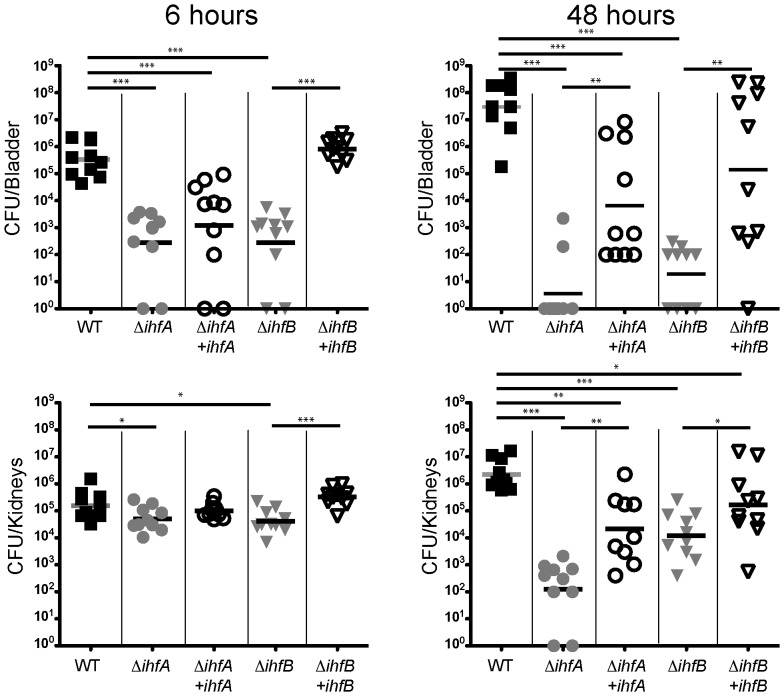
IhfAB subunits are required for UPEC pathogenesis.Each symbol represents single infected murine bladder or combined kidney pair. Female mice were infected with wild type UTI89 (black filled squares), ROL745 (UTI89 ihfA11; gray filled circles), ROL745/pHNα (UTI89 ihfA11 complemented with ihfA; black open circles), ROL603 (UTI89 ΔihfB; gray filled triangles), or ROL603/pHNβ (UTI89 ihfB::Cam complemented with ihfB; black open triangles) for 6 or 48 hours post inoculation. Bacterial burden of bladders and kidneys was enumerated as colony forming units ( CFUs). Statistical significance determined using non-parametric Mann Whitney (*<0.04, ** = 0.018, *** = 0.0017, ****<0.0006).